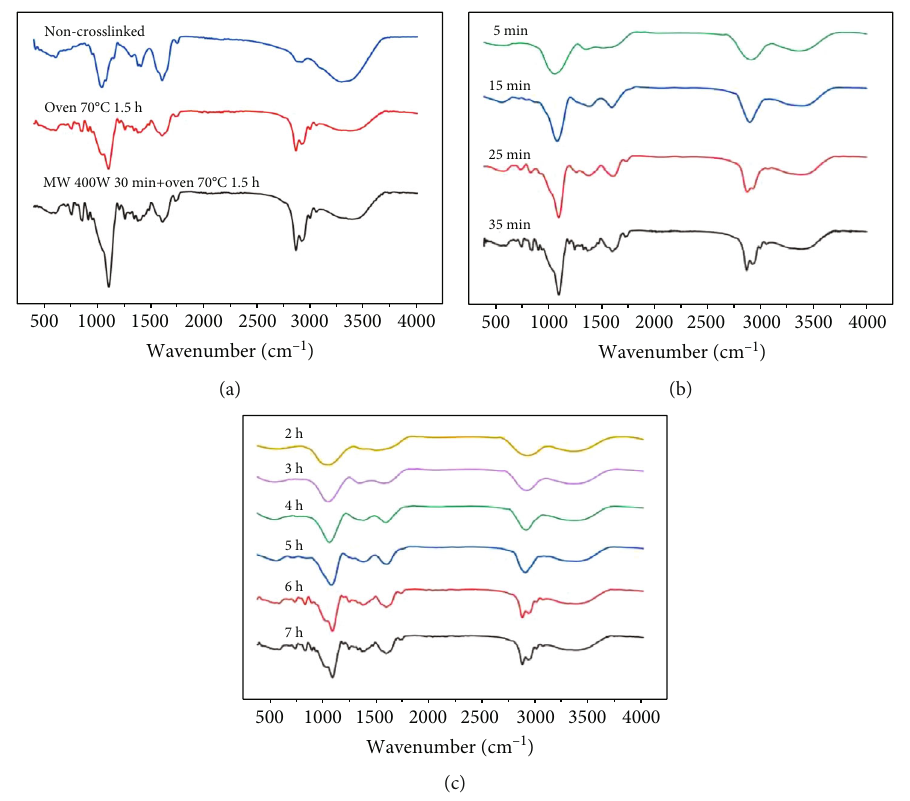
Figure 7: ATR-FTIR spectra of non-crosslinked, conventionally crosslinked, and MW crosslinked hydrogels (a). Using conventional (b) and microwave-assisted (c) crosslinking methods, ATR-FTIR with di ff erent crosslinking times was